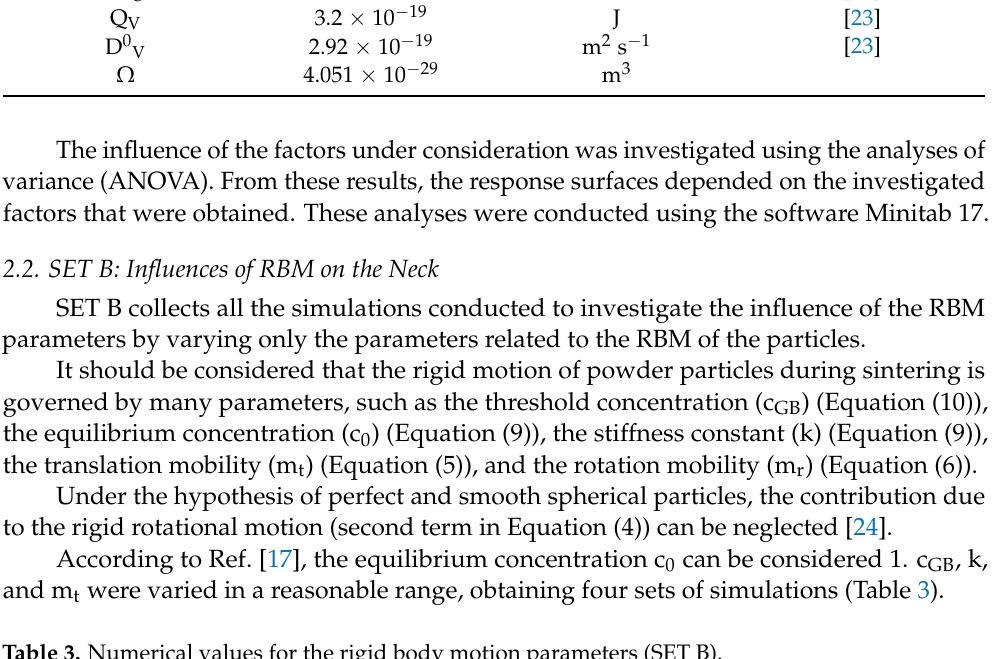
Table 3. Numerical values for the rigid body motion parameters (SET